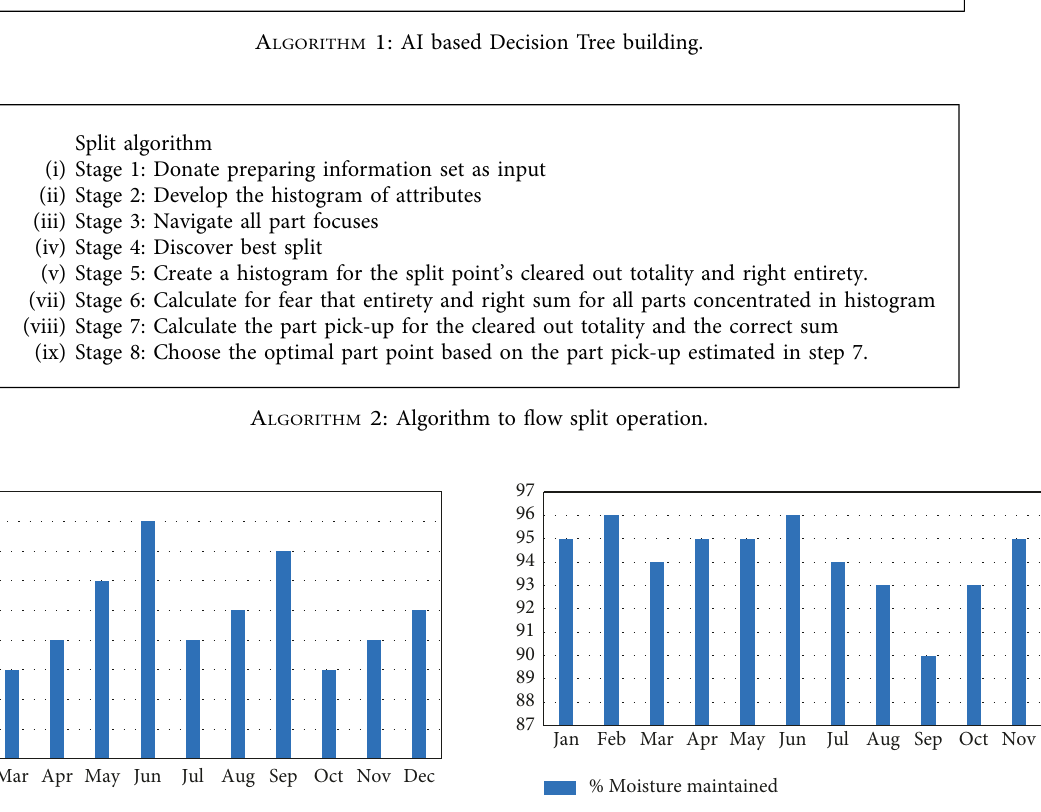
Figure 5: % of moisture